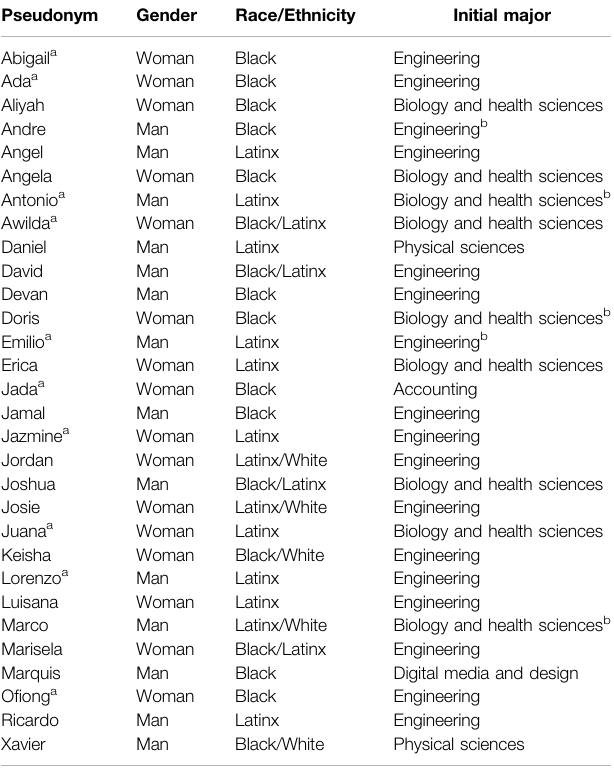
TABLE2| First-yearstudentpro fi leof2016 – 2021LSAMPalliancecohort( n (cid:1) 30). Pseudonym